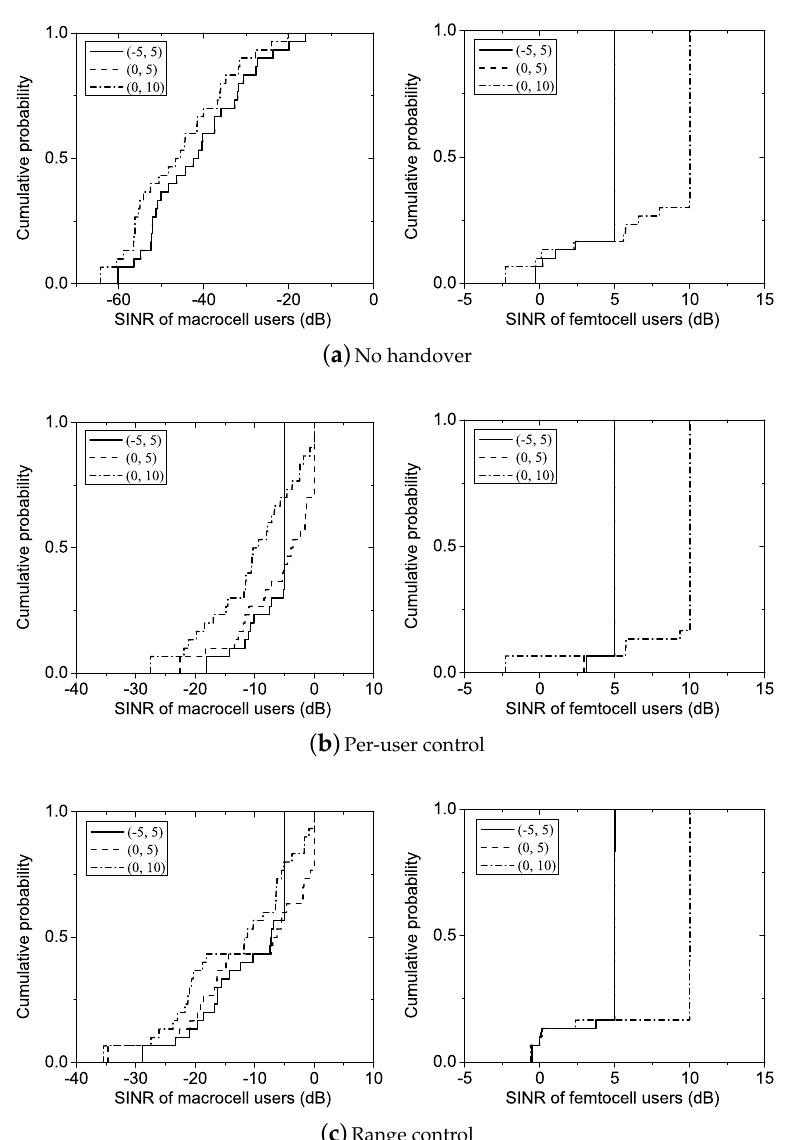
Figure 9. Probability distribution of users’ achieved SINRs for (macrocell users’ target SINR (dB), femtocell users’ target SINR (dB)) ( M = 30, F =